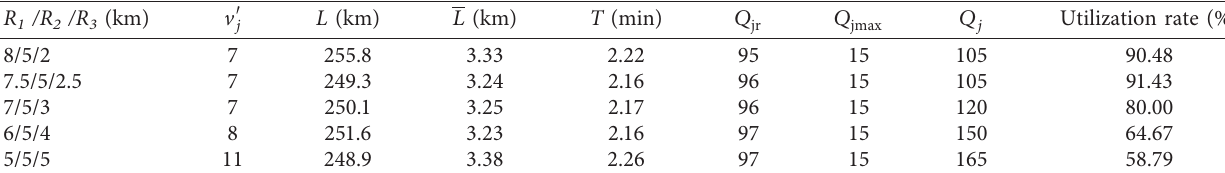
Table 5: Simulation results in scenario